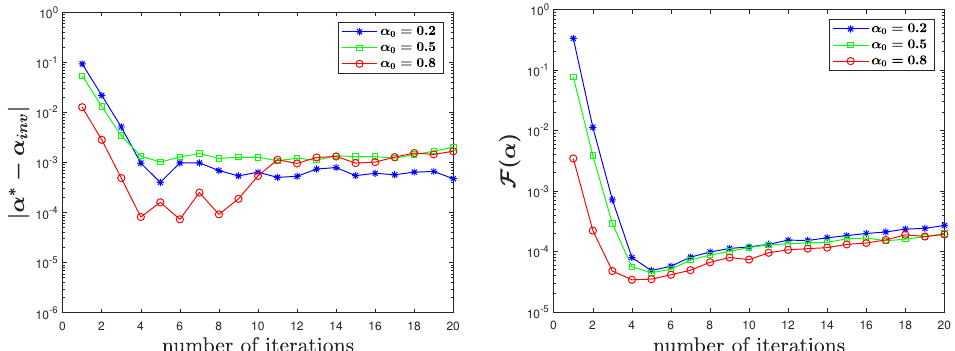
Figure 6. α ∗ = 0.75 for contaminated observation data with 0.1% of noise in Test 2.